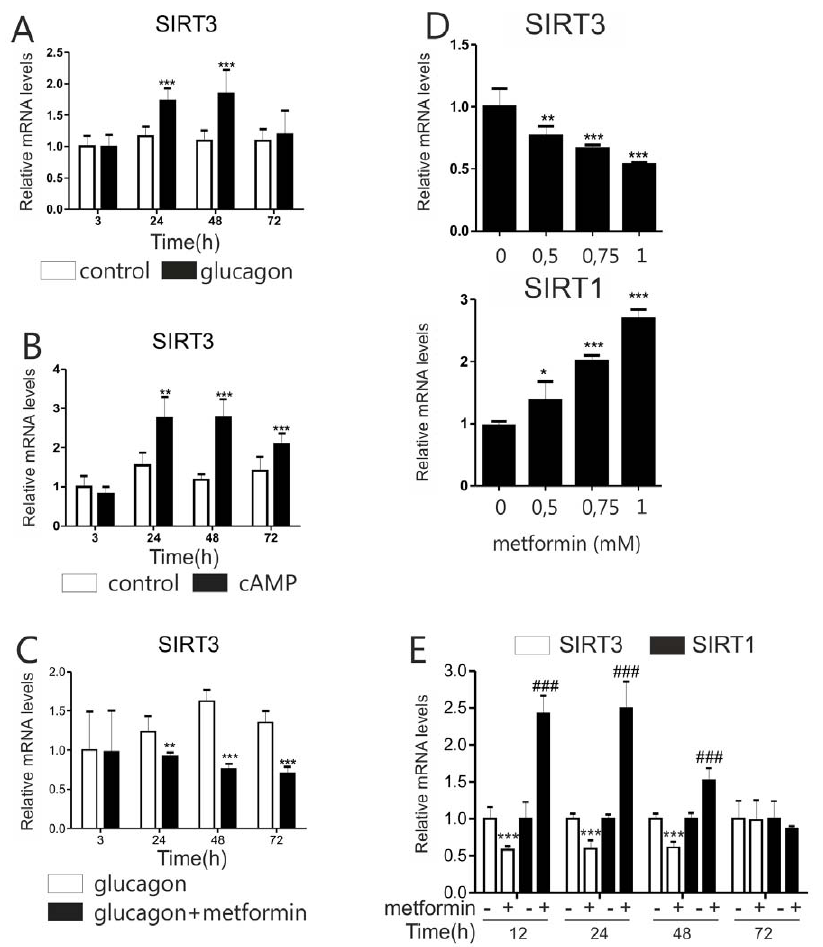
Figure 1. SIRT3 expression is regulated by glucagon, cAMP and metformin. Effect of A) glucagon (5 m g/ml), B) cAMP (50 m M 8-Br-cAMP) and C) glucagon (5 m g/ml) combined with metformin (1 mM) on SIRT3 expression in mouse primary hepatocytes. Cells were collected at indicated time points and expression of SIRT3 mRNA measured with qPCR. D) Mouse primary hepatocytes were treated with metformin as indicated and collected after 24 hours. mRNA levels were measured with qPCR. In panels A-D, the data are presented as mean + SD (n=3). Statistical significance to control samples *P , 0.05, **P , 0.01, *** P , 0.001 (ANOVA, Bonferroni post hoc test). E) Mouse primary hepatocytes were treated with 1 mM metformin, collected as indicated and the mRNA levels were measured with qPCR. The values are presented as mean + SD (n=4) and relative to the untreated samples at each time point. Statistical significance for SIRT3 and SIRT1 was calculated independently. SIRT3 *** P , 0.001; SIRT1 ### P , 0.001 (ANOVA, Bonferroni post hoc